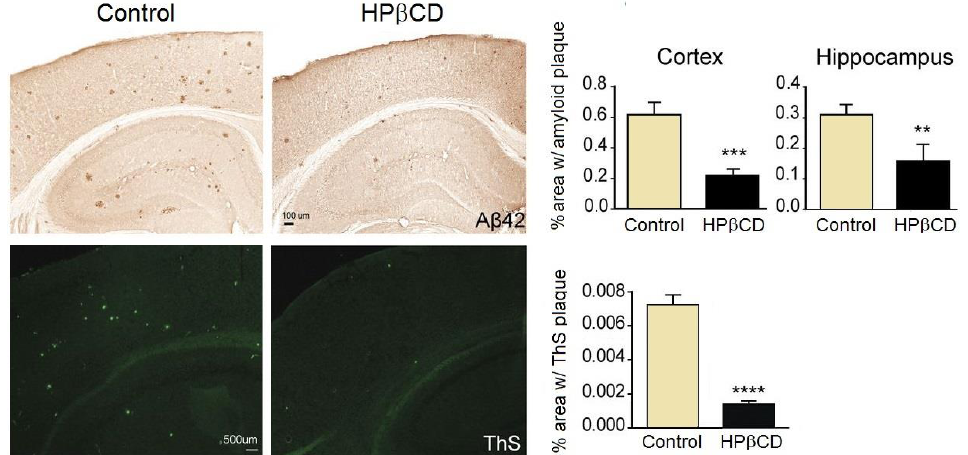
Figure 4. HPβCD treatment significantly reduces amyloid plaque burden in Tg19959 mice at four months of age . Top row: representative images of amyloid plaques detected with an Aβ42 antibody, along with the calculated percentage of area covered by amyloid plaques in cerebral cortex and hippocampus of Tg19959 mice treated with saline (control) or HPβCD. Bottom row: representative images of amyloid plaques stained with thioflavin (ThS), a fluorescent stain that binds to beta-sheet rich regions of amyloid plate. The chart depicts the percentage of brain tissue area covered by ThS-positive plaques. **, p < 0.01; ***, p < 0.001; ****, p < 0.0001; n = 9 – 10 in each group. All results were obtained and analysed from two separate animal studies. Reproduced from Yao et al. [65] under a Creative Commons licence (CC BY-NC-SA 3.0).